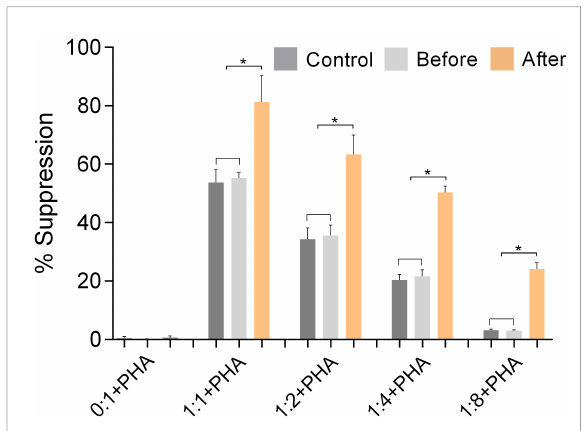
FIGURE 6 Relative mRNA gene expression of signature transcription factors of Th cell populations ROR- g t (Th17), Tbet (Th1), GATA-3 (Th2), FoxP3 (Tregs), and Ets-2 (pre-Th0) in PBMCs from marathon runners before and after the race and from control subjects. Data are shown as mean (SD).